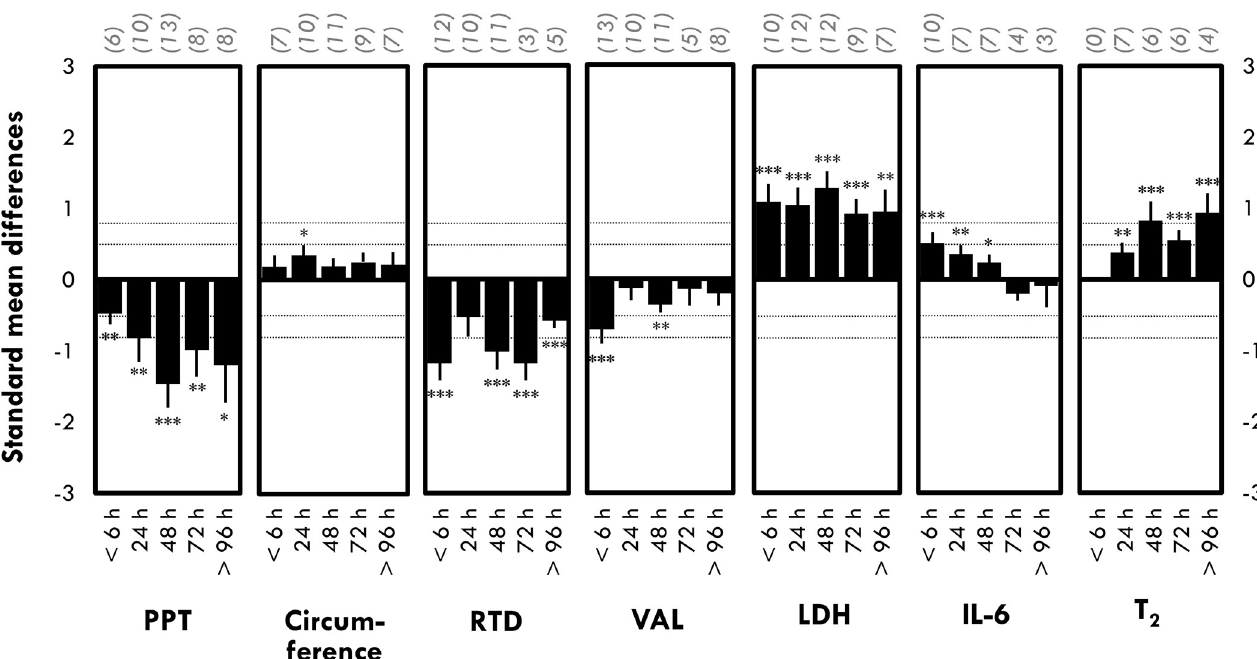
Fig 3. Time-course changes in pain pressure threshold (PPT), limb circumference, rate of torque development (RTD), voluntary activation level (VAL), lactate dehydrogenase (LDH), interleukin-6 (IL-6) and transverse relaxation time (T 2 ) at < 6 h, 24h, 48h, 72h and > 96 h post-exercise. The number in parenthesis represents the number of studies. Data are displayed as mean of standard mean difference (SMD) ± standard error. � : Significant difference from baseline at p < 0.05; � : �� : Significant difference from baseline at p < 0.01; ��� : Significant difference from baseline at p < 0.001.